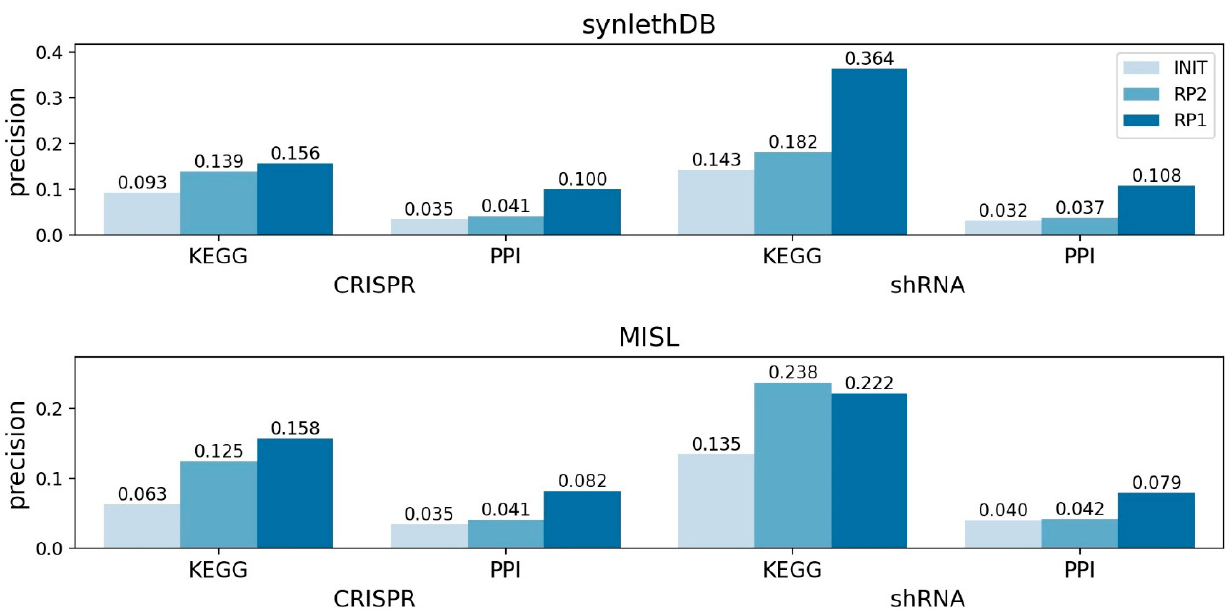
Figure 7. The precision of the sensitive GIs with no RP, RP2, and RP1. The sensitive GIs refined based on KEGG/PPI networks were evaluated with the SLIs in synlethDB and MISL. For most comparisons, RP1 exhibited the highest precision, followed by RP2 and then INIT. INIT: the initial sensitive GIs after mapping on the molecular networks (no RP was applied). RP2: the sensitive GIs after applying RP2 to the initial GIs. RP1: the sensitive GIs after applying RP1 to the initial GIs. RP: refining process. GI: genetic interaction.